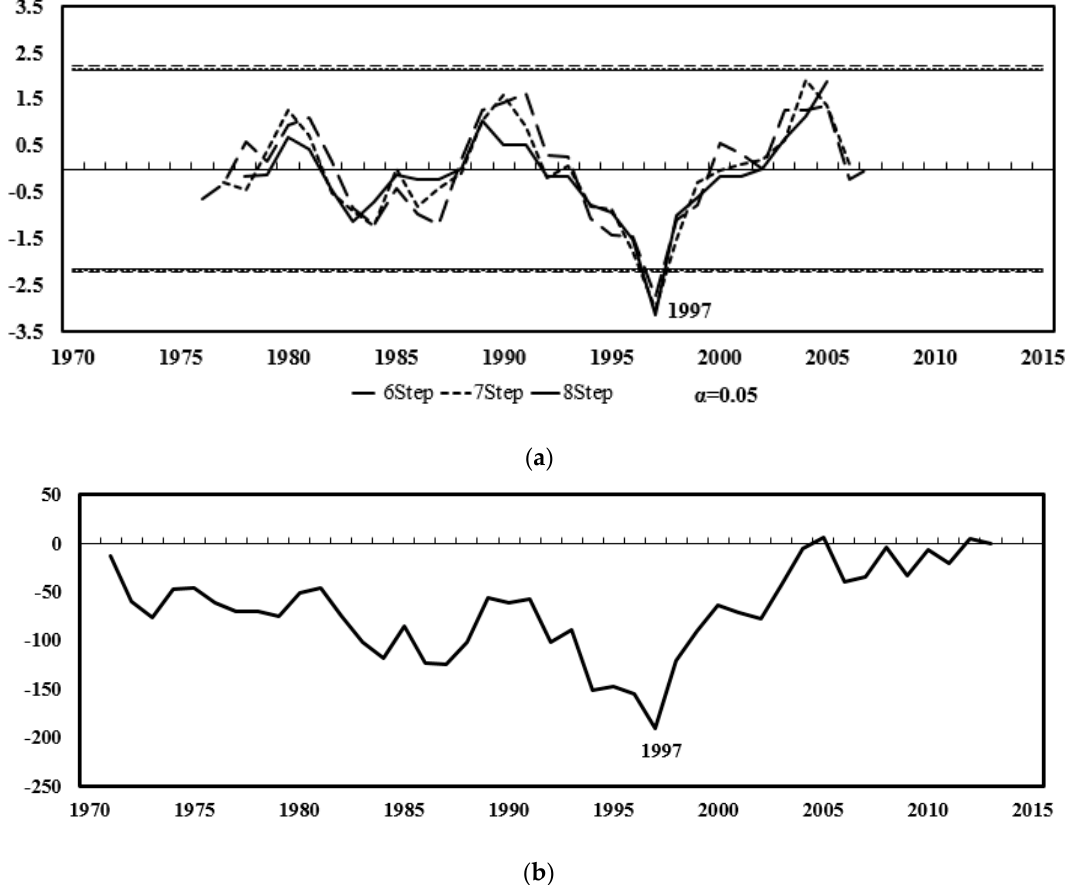
Figure 5. Mutation of the annual precipitation over the TP ( a ) moving t -test; ( b ) cumulative anomaly.